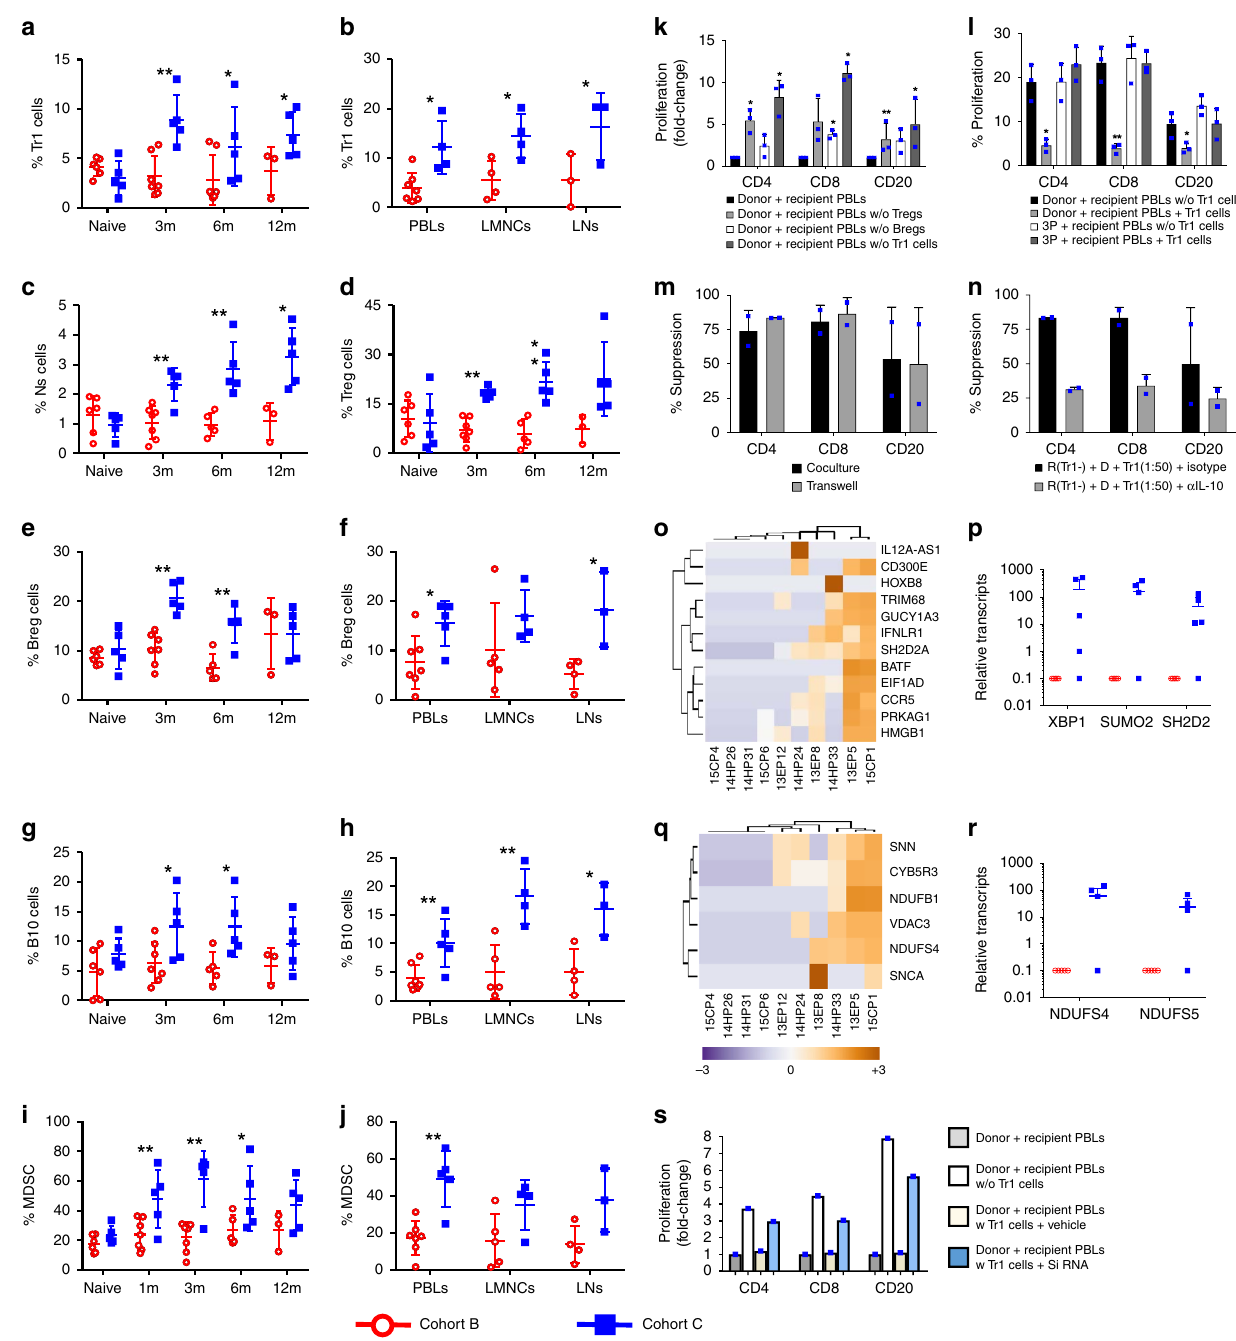
Sensitization impedes the tolerogenic ef fi cacy of ADLs . In Cohort E monkey #15FP13 (not given ADLs), DSA were present at baseline but did not preclude prolonged islet allograft survival (Supplementary Table 1; Fig. 5h). In Cohort E monkey #13EP3 (given ADLs), cellular (but not humoral) memory alloreactivity was demonstrated at baseline, as was transient allograft function (Supplementary Table 1; Fig. 5i). However, in Cohort E monkeys #14HP21 and #14HP29 (both given ADLs), DSAs at baseline were associated with accelerated islet allograft loss (Fig. 5j, k). In Cohort E, posttransplant expansion of TEM cells was not sup- pressed (Fig. 5l) nor did circulating regulatory subsets expand even after ADL infusions (Fig. 5m). Also, donor-speci fi c pro- liferation of CD4 + and CD8 + T cells was not inhibited (Fig. 5n,